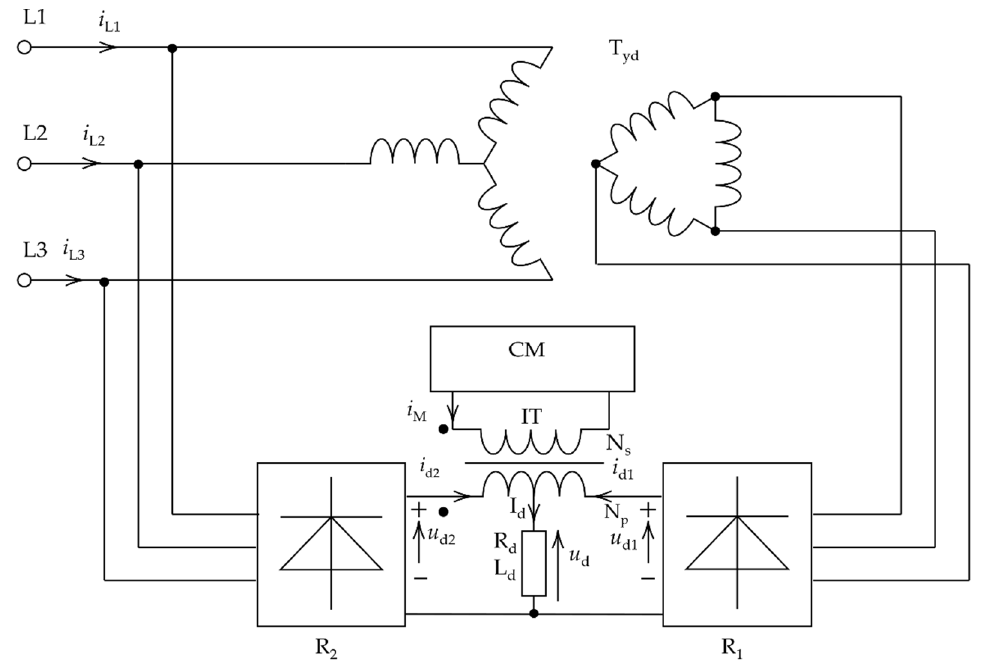
Figure 4. Schematic diagram of the rectifier with the current modulator (CM).